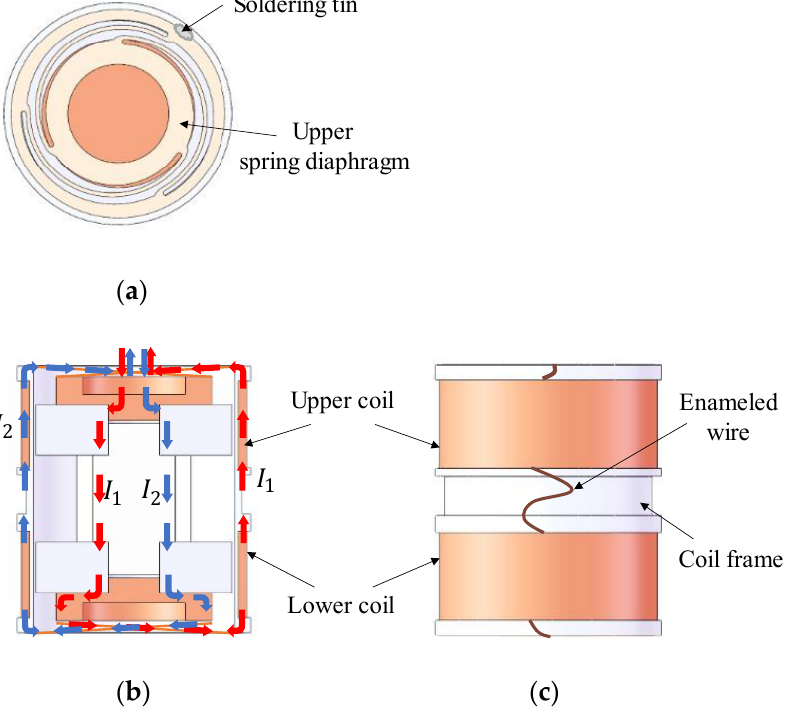
Figure 13. The internal structure of a dual-magnet velocity sensor. ( a ) Top view; ( b ) front view, which is full sectioned; ( c ) left view.